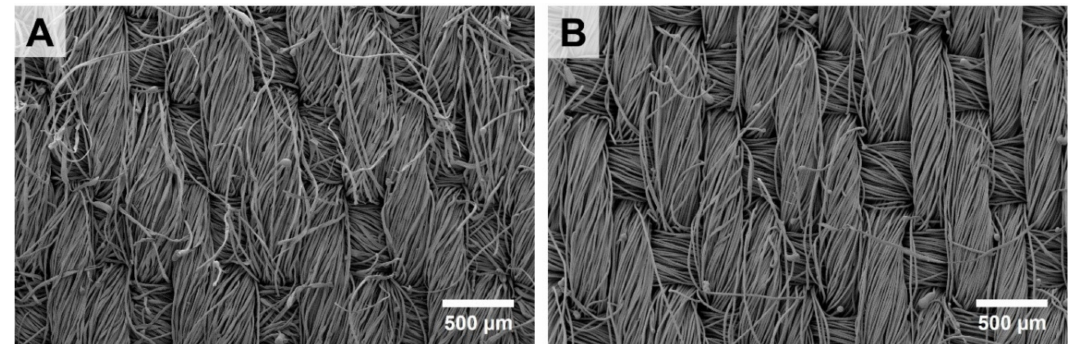
Figure 6. SEM-images of a 50 / 50 polyester-cotton intimate blended fabric. ( A ) Surface of the untreated fabric ( B ) Fabric surface after treatment with concentrated sulphuric acid. It shows a more aligned structure and a smoother surface after sulphuric acid incubation, confirming the removal of